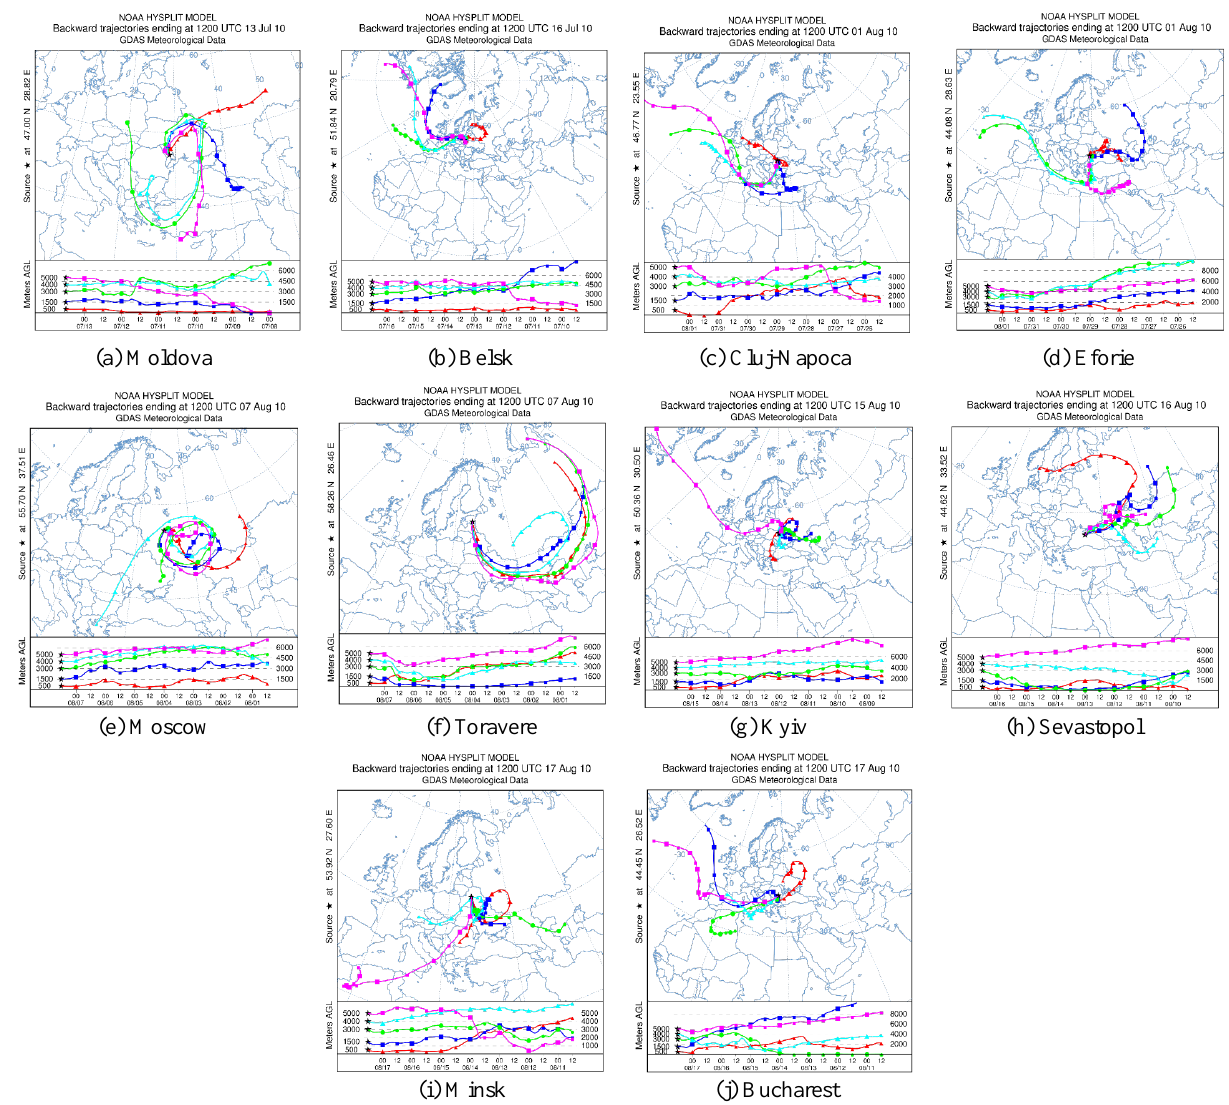
Figure 4. Back trajectories of air masses to the AERONET sites for dates of maximum AOD during summer 2010 (refer to Table 1).